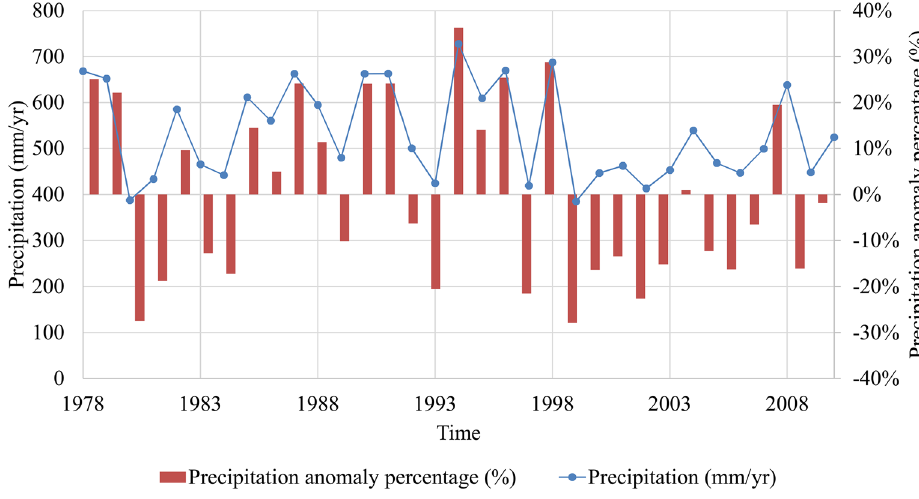
Figure 8. Average annual precipitation in the Beijing area from 1978 to 2010.